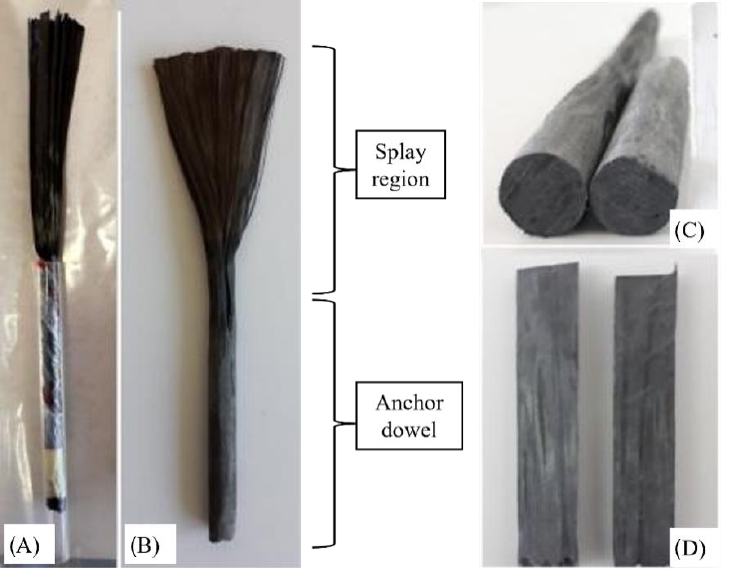
Figure 2. FRP anchor made from carbon rope, with precured anchor dowel. ( A ) Pre-impregnation with epoxy resin; ( B ) Precured anchor; ( C ) Cross section of hardened anchor dowel; ( D ) Inspection of inner impregnation of anchor